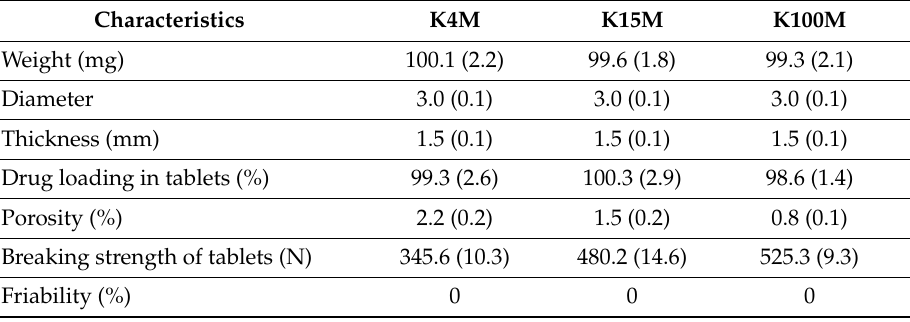
Table 4. Geometrical and morphological characteristics of 3D printed hydrophilic matrices (n = 5, standard deviations are in